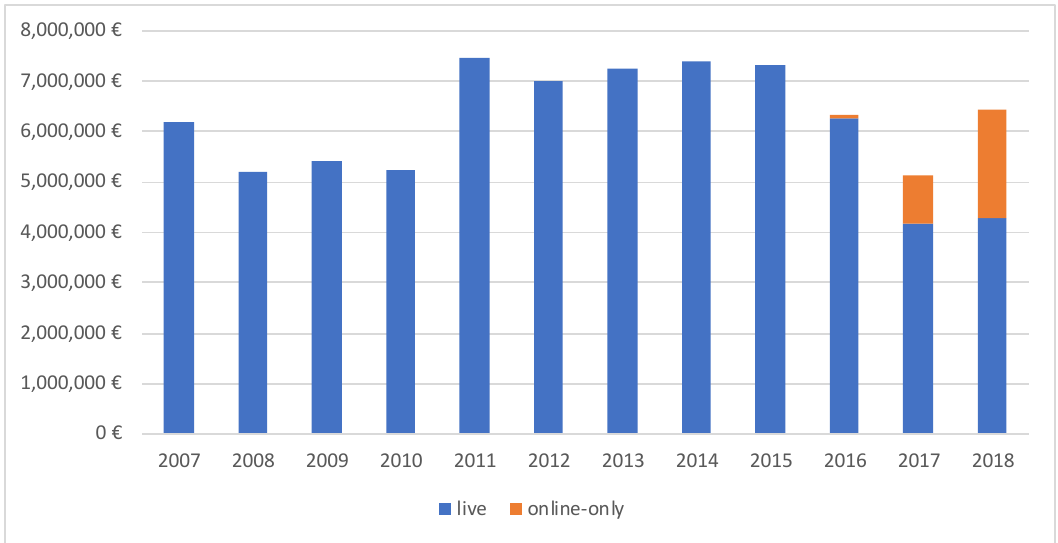
Figure 5. CML’s turnover with the contribution of online -only auctions (2007 – 2018).